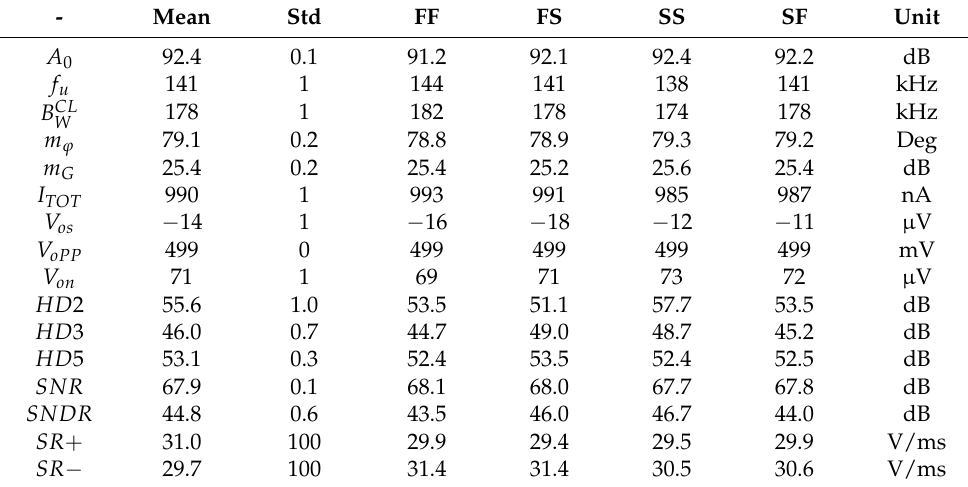
Table 5. Monte Carlo simulation results (process only) and corner simulations.